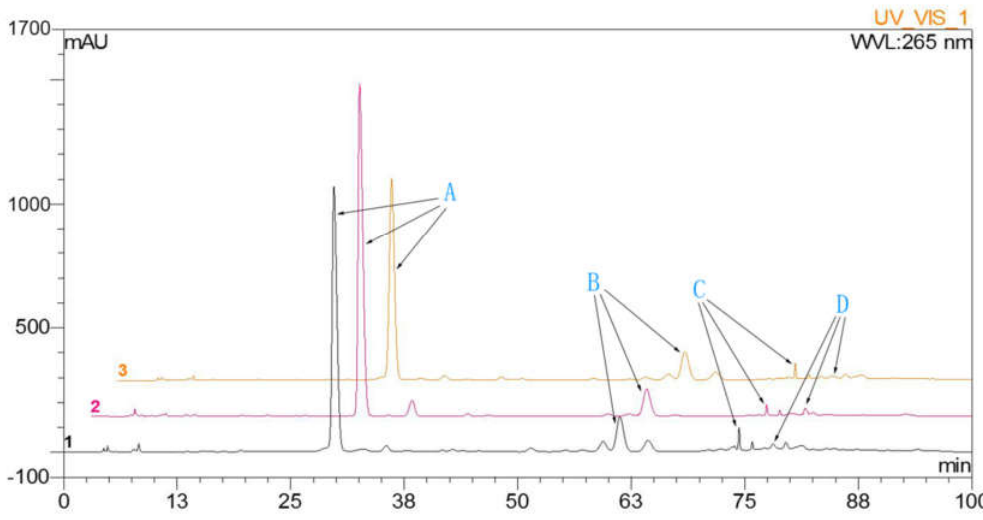
Figure 1. The HPLC chromatographic: A, dihydromyricetin; B, myricitrin; C, quercitrin; D, myricetin.